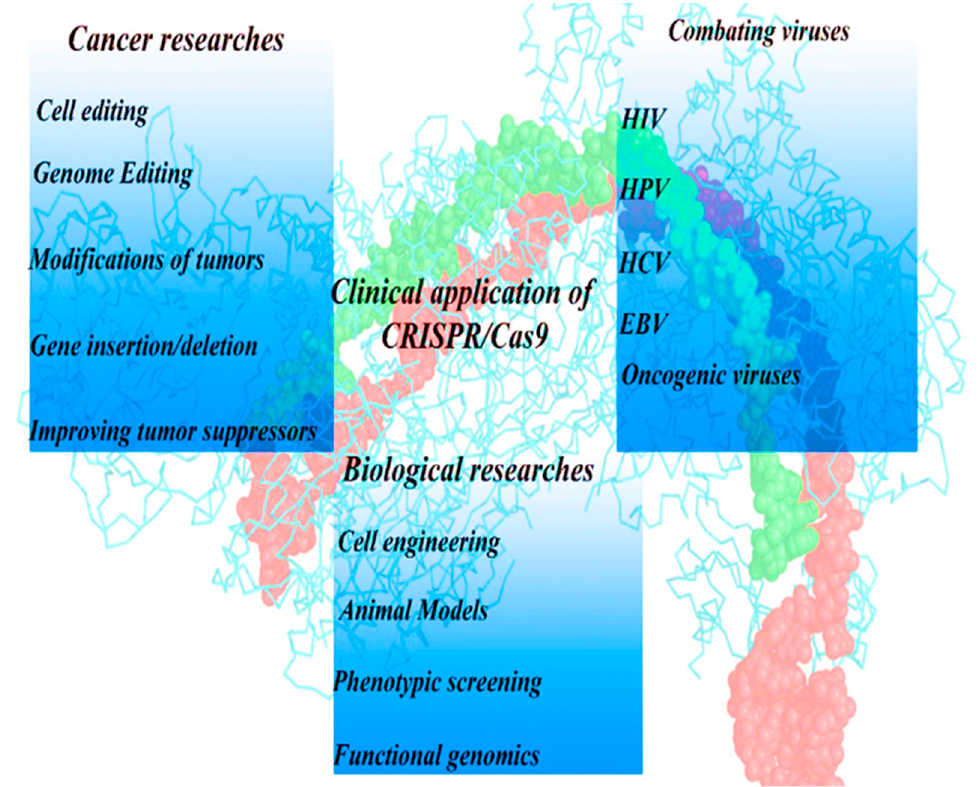
Figure 2. Exploitation of the CRISPR-Cas9 system in the field of medicine, including infectious diseases, tumors, and genetic diseases.